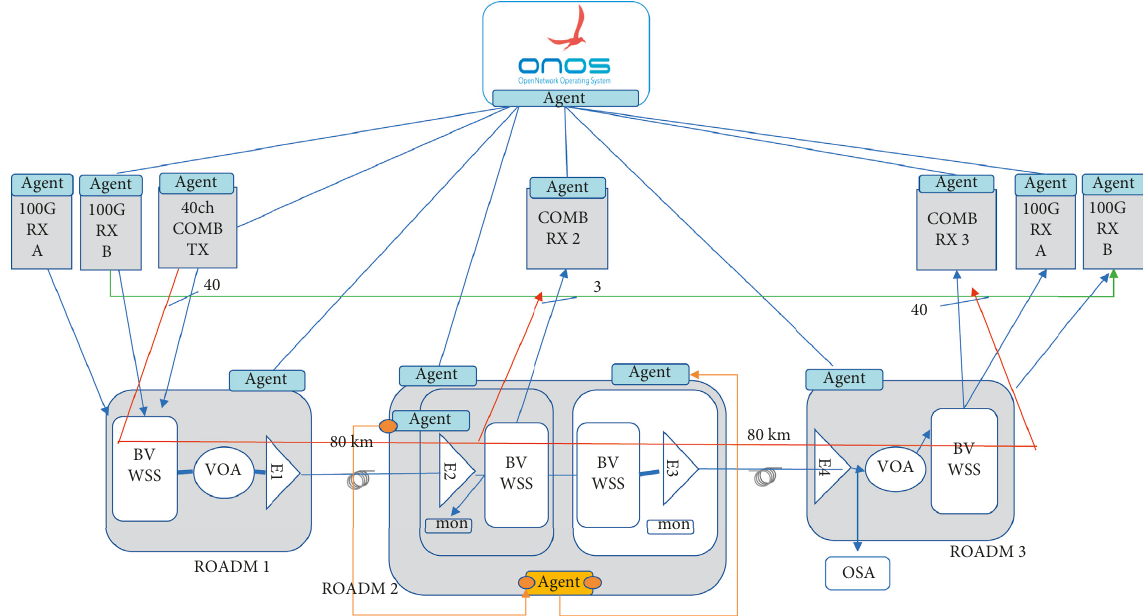
Figure 16: ROADM architecture and network testbed